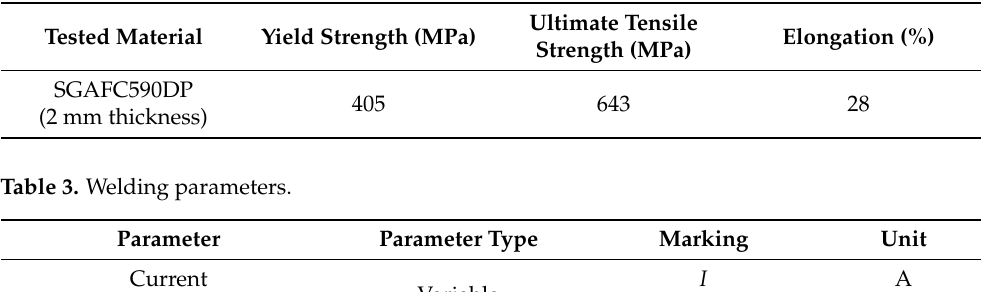
Table 2. Mechanical properties of the tested material.